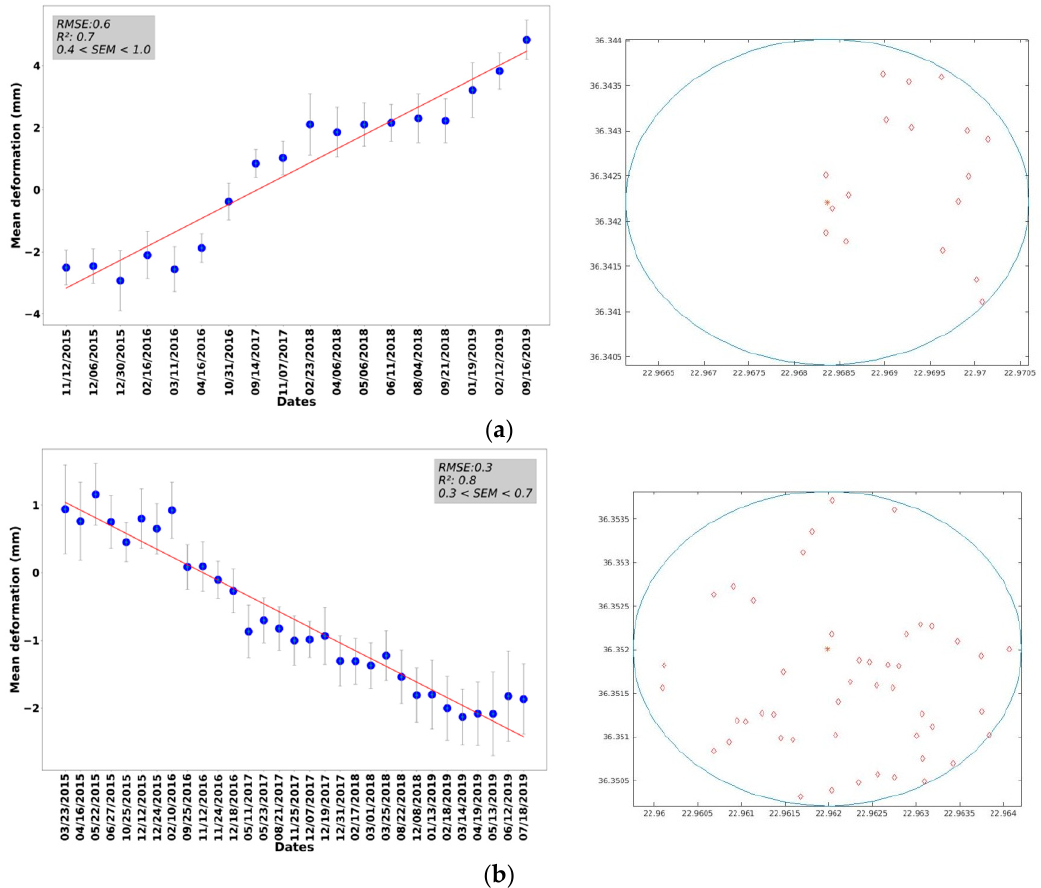
Figure 8. Time-series plots for scatterers included in 200-m radius near the Potamos coast ( a ) Sentinel-1 ascending track no. 102; ( b ) Sentinel-1 descending track no. 7.